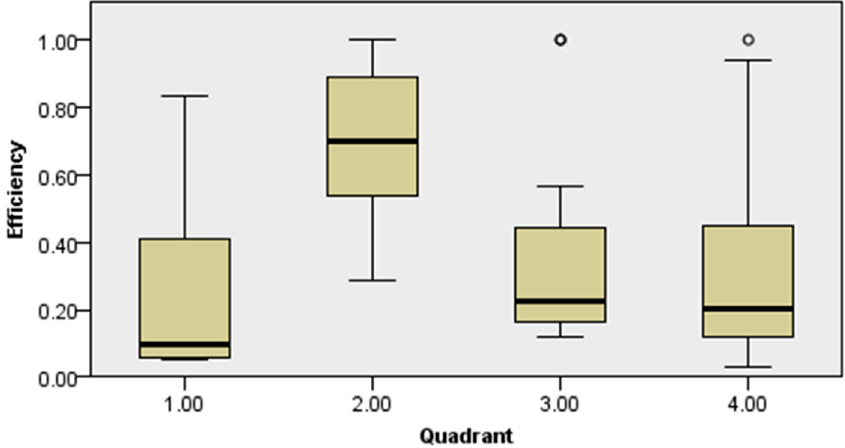
Figure 4. Box and whisker plot of innovation efficiency by quadrants.